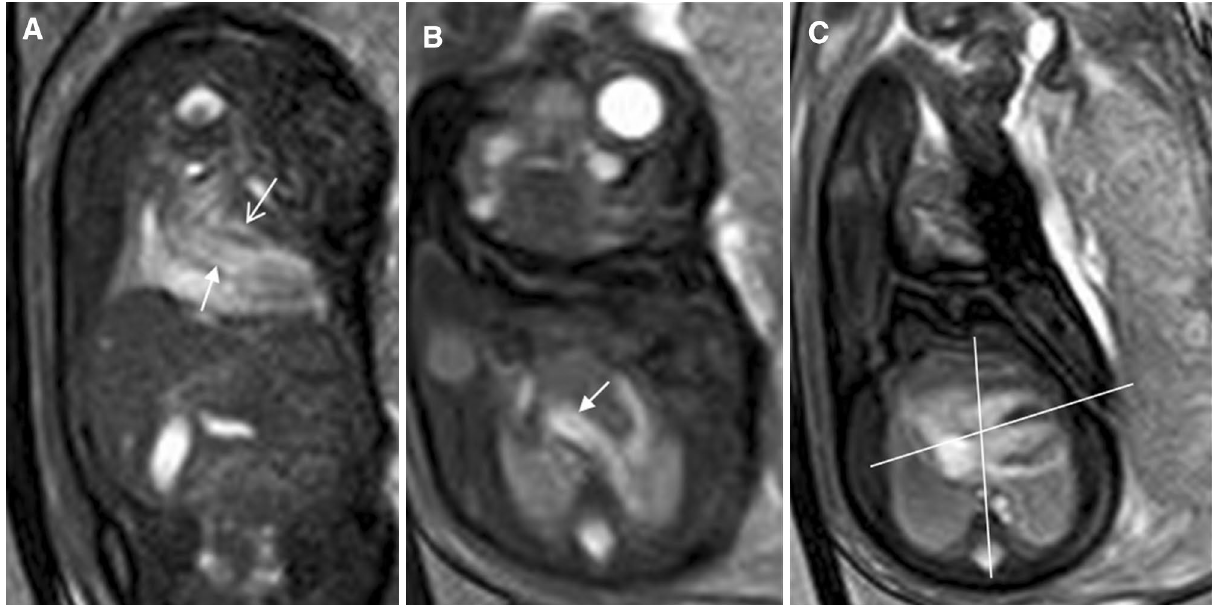
Figure 6. A 28-week-old foetus with a TOF referred for a foetal cardiac MRI because of oligohydramnios. Foetal CMR SSFP coronary and axial view images showing the oligohydramnios and stenosis of the right ventricle outflow tract (open arrow in A ), the enlarged ascending aorta (arrow in A ), the aortic arch (arrow in B ), and the turning right cardiac axis (the angle between the line through the foetal spine and sternum and the interventricular septum in C